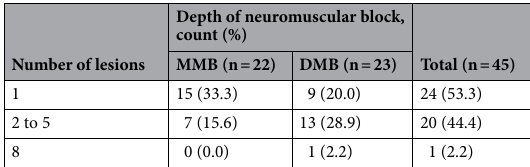
Table 3. Number of lesions by depth of neuromuscular